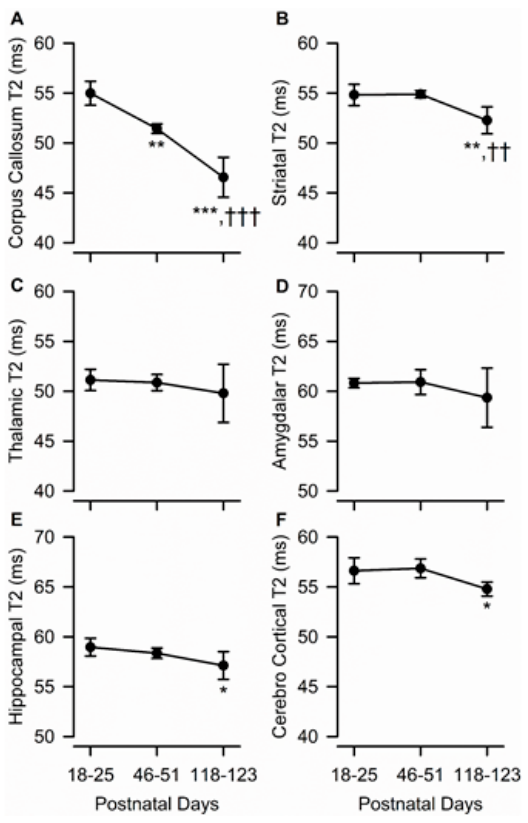
Figure 6. Age dependence of T2 measures obtained from different ROIs of the male guinea pig brain. Graphs illustrate the age dependence of T 2 measures obtained from the corpus callosum ( A ), striatum ( B ), thalamus ( C ), amygdala ( D ), hippocampus ( E ), and cerebral cortex ( F ) in the brain of male guinea pigs. Symbols and error bars represent mean and SD of results obtained from six guinea pigs examined longitudinally at PND 18-25, PND 46-51, and PND 118-123. Whenever ANOVA revealed a significant effect of age on a given parameter, the Tukey post-hoc test was used for multi-group comparisons. Asterisks and daggers are used for comparison, with data obtained at PND 18-25 and PND 46-51, respectively. *, p < 0.05, **, p < 0.01, ***, p < 0.001; ††, p < 0.01; †††, p < 0.001.